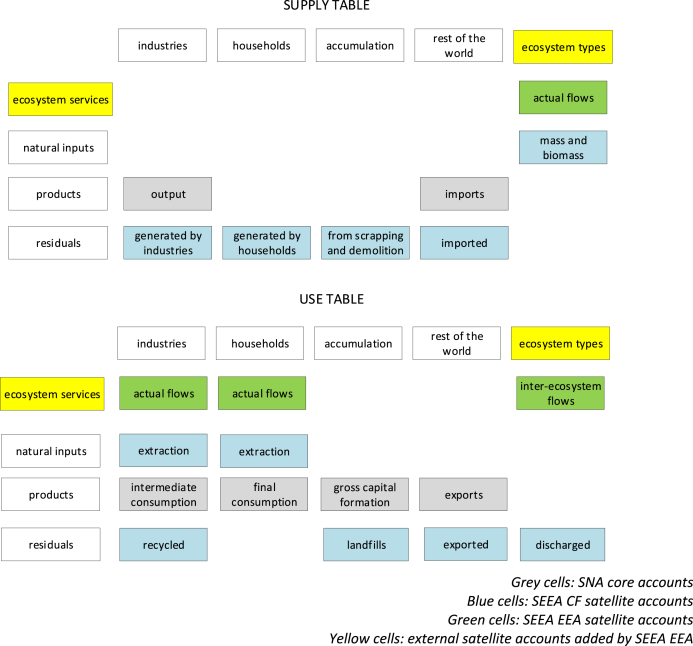
Graphical simplification of Supply and Use tables in the SEEA EEA (source: adapted from La Notte et al., 2017b).